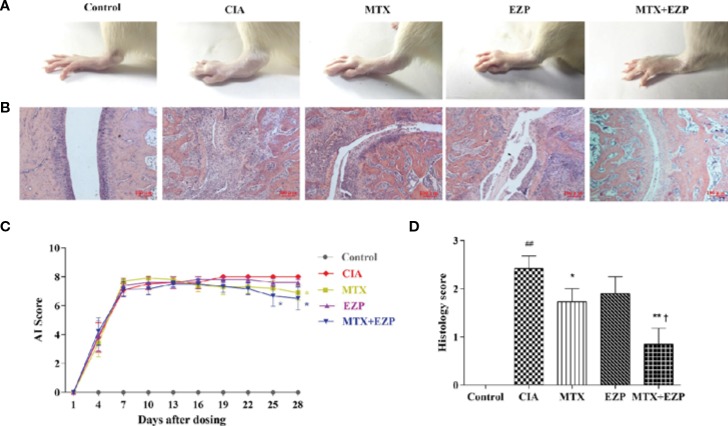
Effects of EZP combined with MTX on arthritis severity in CIA rats. (A) Representative images of the ankle joints after treatment. (B) Representative images of ankle pathology. (C) AI score of each group. (D) Histological score of each group. ##P < 0.01 compared with the control group; *P < 0.05, **P < 0.01 compared with the CIA group; †P < 0.05 compared with the MTX group.